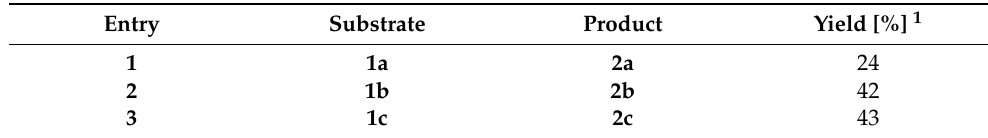
Figure 2. The reaction of benz[ a ]azulenes 1a − 1c with PHBPB. Table 1. Synthesis of benz[ a ]azulenequinones 2a − 2c .